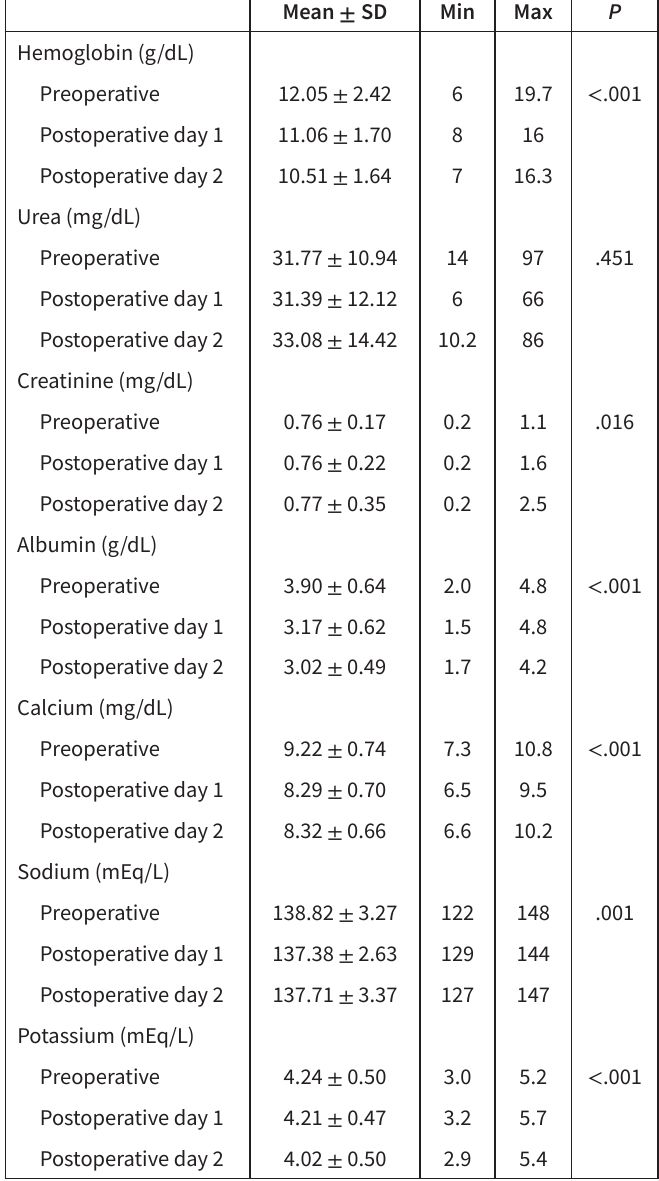
Table 1. Preoperative and Postoperative Laboratory Parameters of the